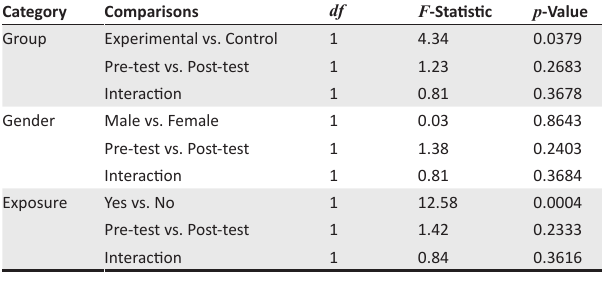
TABLE 2: A summary of the ANOVA results when analysing group, gender and exposure over the pre-test and post-test. Category Comparisons